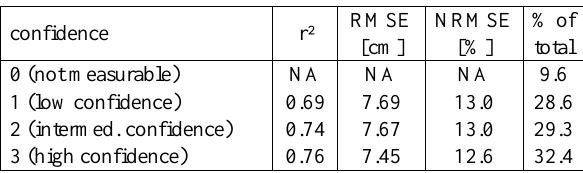
Table 2. Summarized accuracy of the DBH measurements